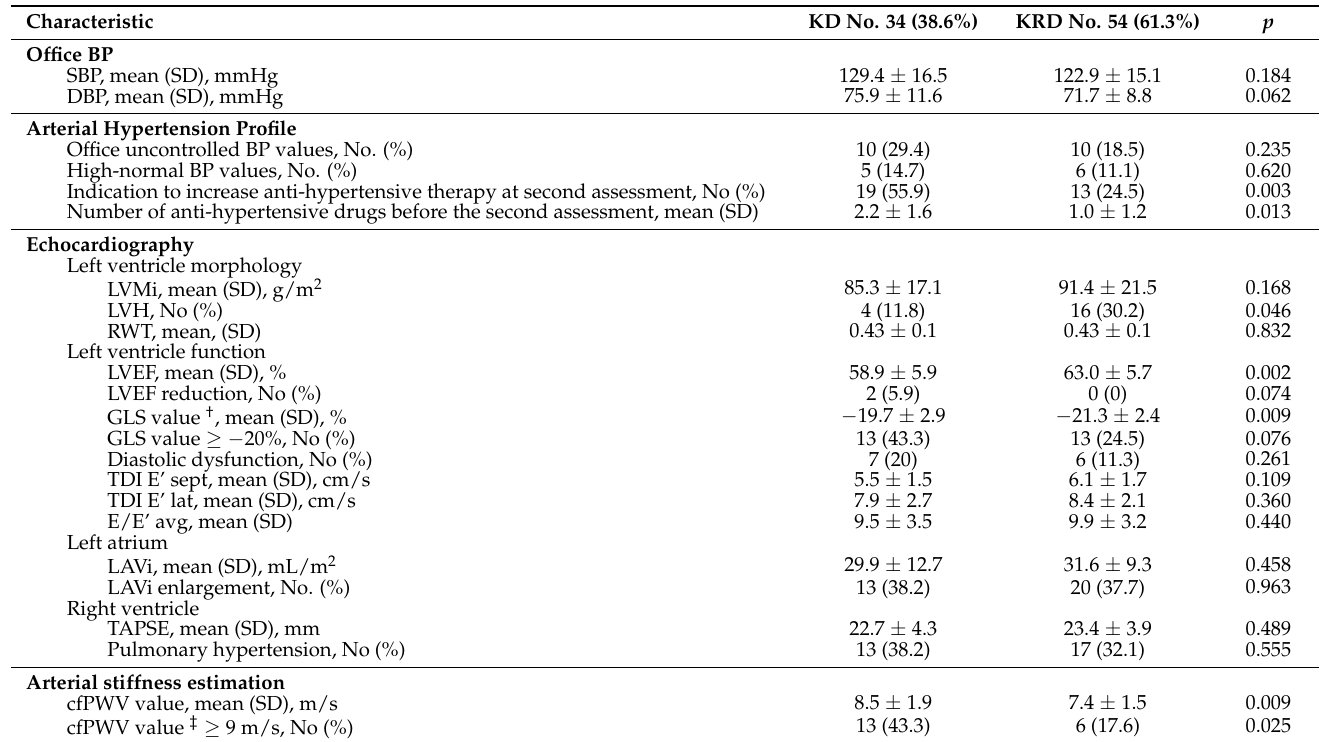
Table 3. Main parameters and subclinical organ damage at the second